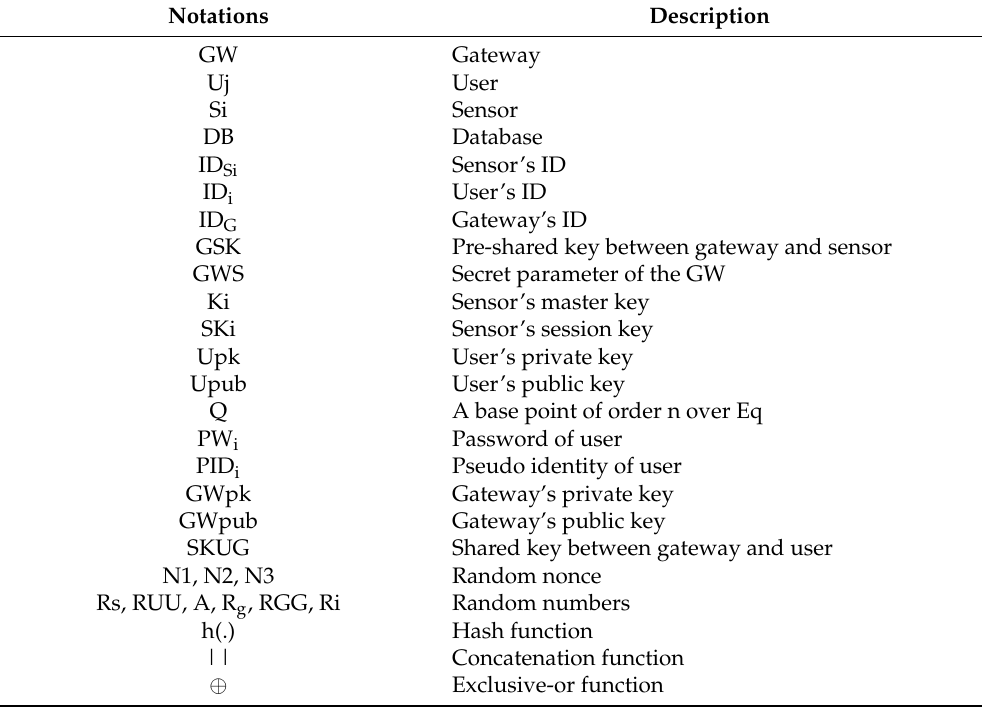
Table 2. Notations of the proposed lightweight authentication MAC protocol for